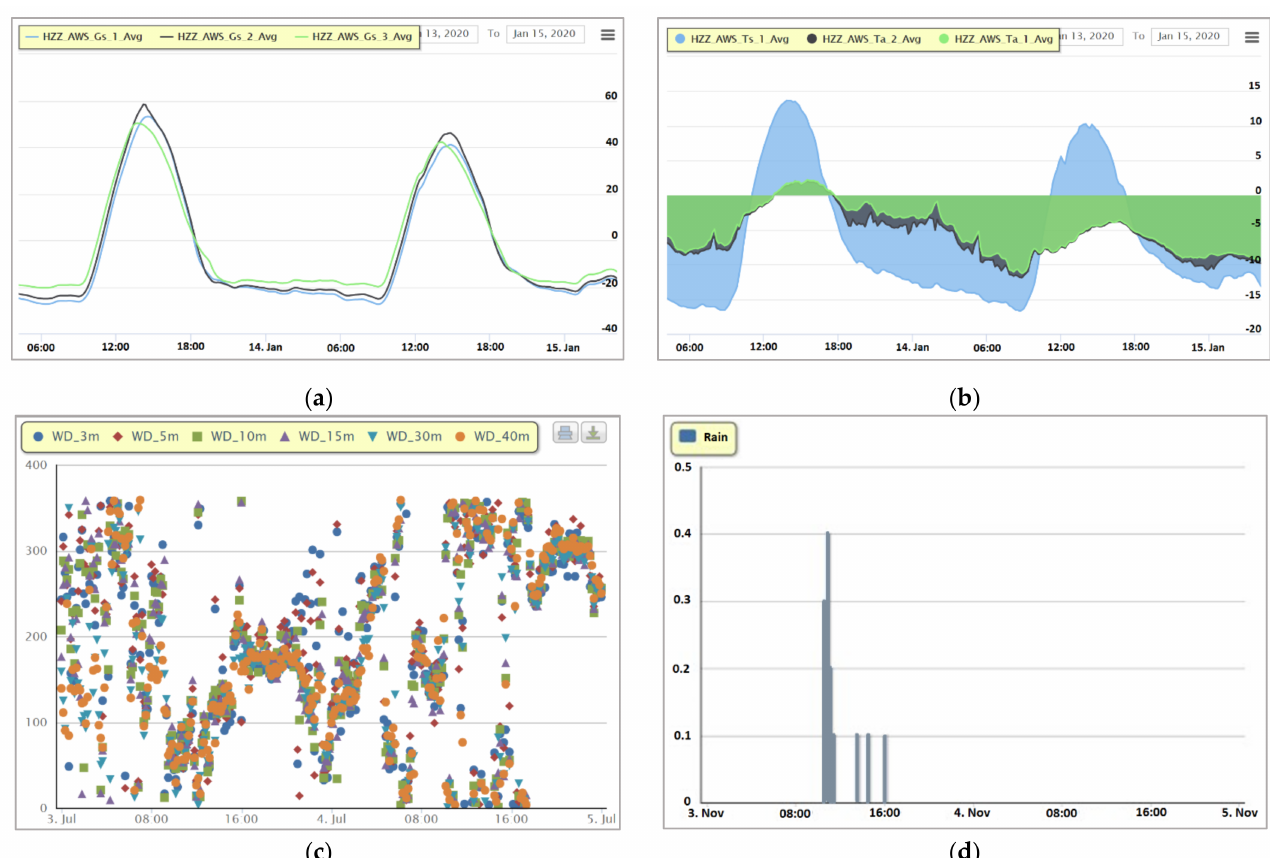
Figure 10. Different online visualization forms of the observational data in the HRB. ( a ) A curve chart example of soil heat flux (in this example, in a corn field near Daman station); ( b ) an area chart example of soil temperature (in this example, 2, 4, and 6 cm underground near Daman station); ( c ) a scatter chart example of wind direction (in this example, near Dashalong station on 4 November 2019); ( d ) a column chart example of rainfall (in this example, near Dashalong station on 4 November